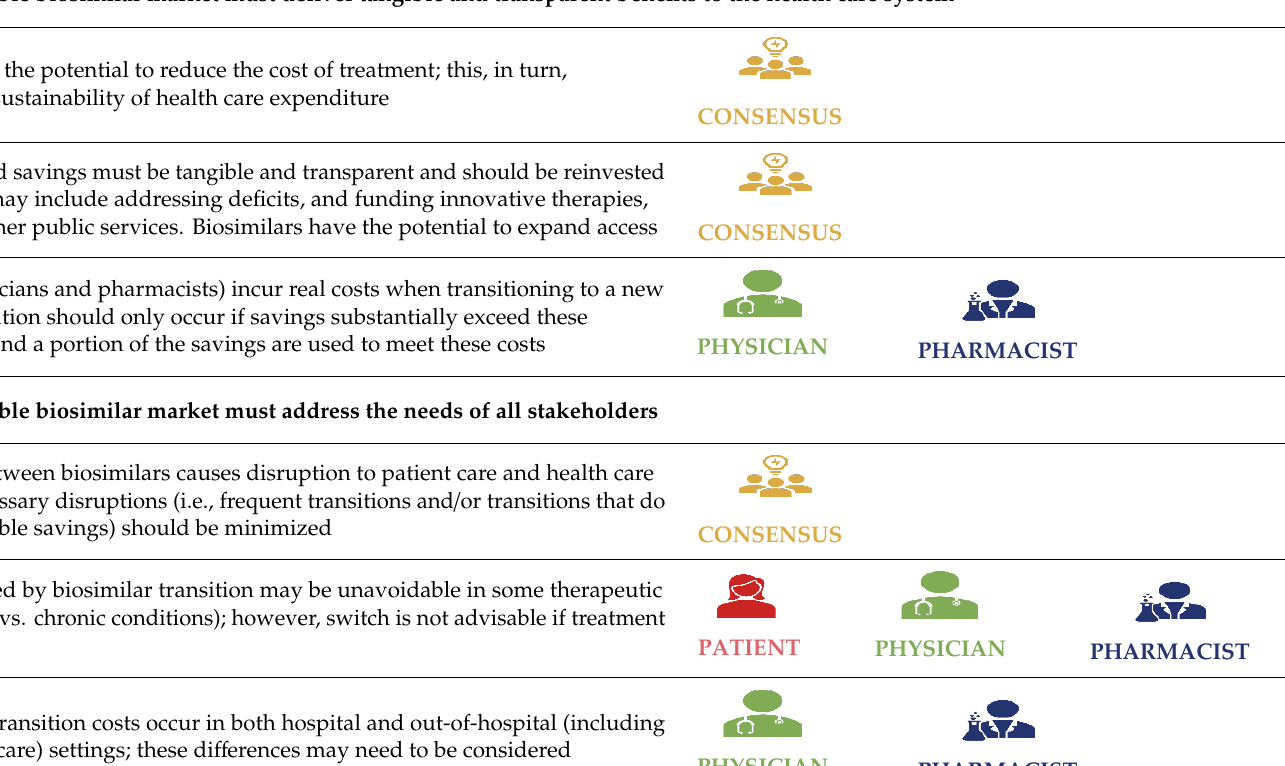
Table 1. Consensus on components of a sustainable biosimilar market.